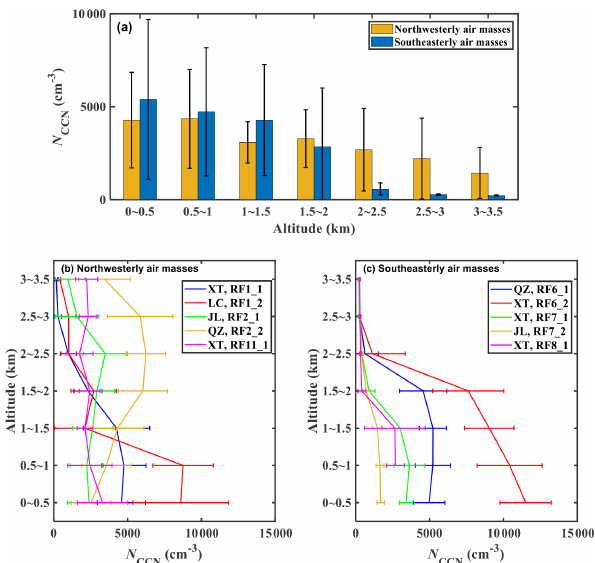
Figure 4. (a) Mean N CCN at 0.7%SS in different altitude ranges (ranging from 0 to 3.5km at intervals of 0.5km) in northwesterly and southeasterly air masses, and for different N CCN profiles at 0.7%SS in (b) northwesterly air masses and (c) southeasterly air masses. The different colors in (b) and (c) are for different flights. Error bars represent standard deviations of N CCN at